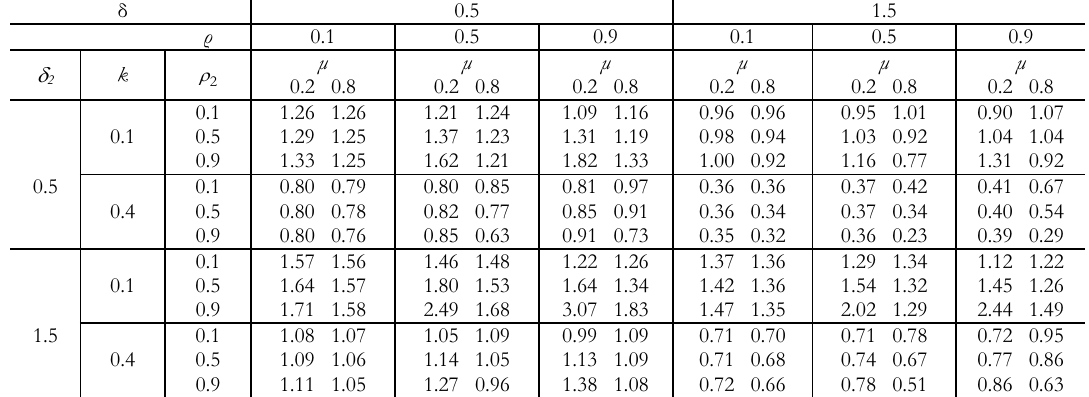
with respect to T 2